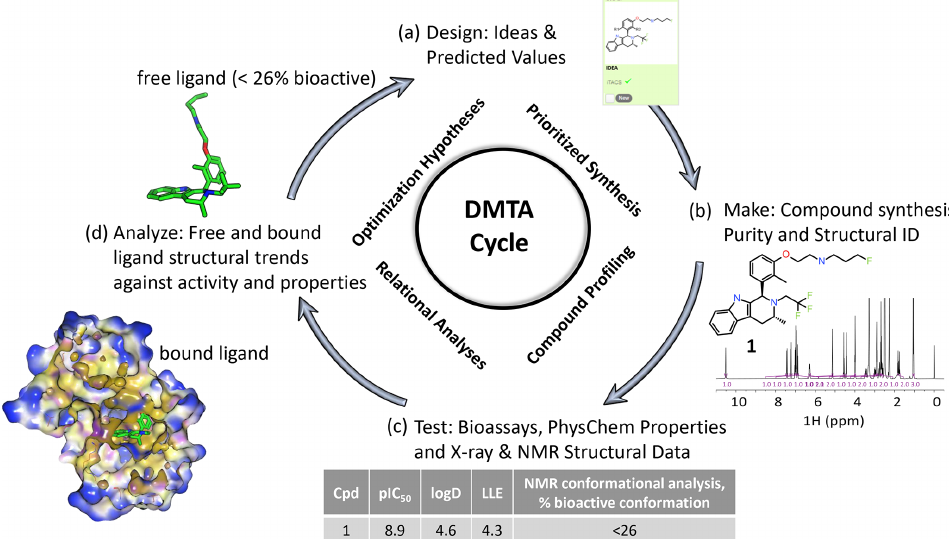
Figure 1. An illustrative medicinal chemistry design–make–test–analyze (DMTA) cycle for drug discovery; the example shown is taken from a recent Oncology R&D project (Scott et al., 2016, 2019, 2020). (a) Design: medicinal chemists design drug molecule ideas, using predicted values from computational models to prioritize which virtual molecules to synthesize. (b) Make: compounds are synthesized and NMR plays a key role in structural identification and analysis of compound purity. (c) Test: compound profiling includes bioassays to quantify activity, such as target inhibition (pIC50), and physico-chemical properties, such as the octanol–water partition coefficient (logD). X-ray structure of the bound ligand–protein complex and NMR free ligand conformations are measured, including the relative population of the bioactive bound conformation (Balazs et al., 2019). (d) Analyze: compound free and bound structures are analyzed against measured properties to rationalize structure activity and property relationships to derive new hypotheses for improved designs in step (a) of the cycle. Typical discovery projects comprise ∼ 1000 cycles from hit to drug